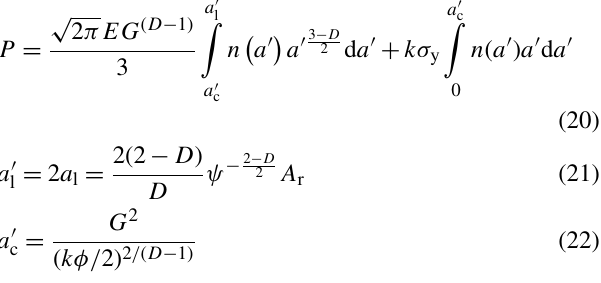
Figure 3. The contact diagram of equivalent sphere single peak and rigid